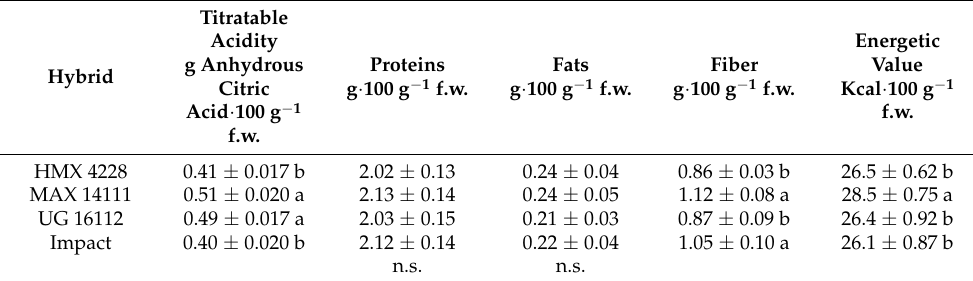
Table 4. Quality features of diced tomato fruits obtained from four hybrids.